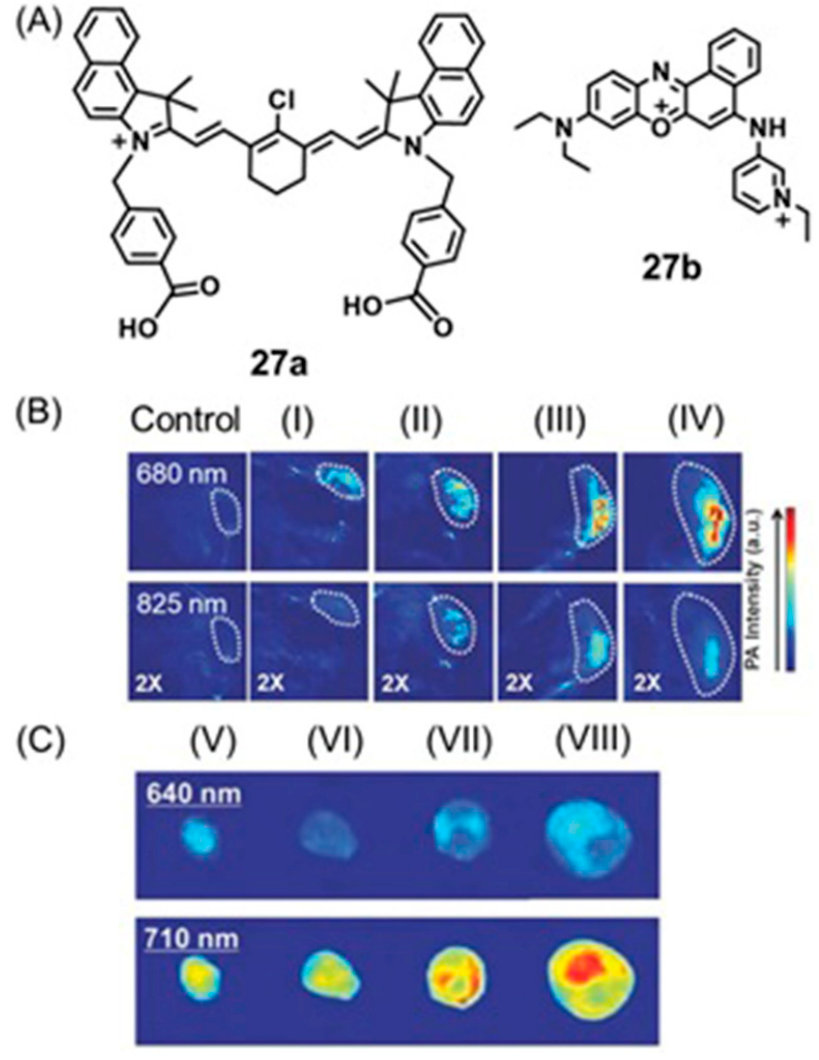
Figure 50. ( A ) Chemical structures of 27a and 27b . ( B ) Photoacoustic images of tumors having different sizes after mice were intravenously injected with the 27a . Images were recorded at 680 and 825 nm excitations (II) 6, (III) 10, (IV) 14, and 18 days after injection. (I) represents the control (tumor without 27a ). ( C ) Ex vivo fluorescence images of tumor with different sizes collected from mice (V) 6, (VI) 10, (VII) 14, and (VIII) 18 days after intravenous injection of 27a . Adapted with permission from Chen, Q.; Liu, X.; Chen, J.; Zeng, J.; Cheng, Z.; Liu, Z. Advanced Materials , John Wiley and Sons [361].